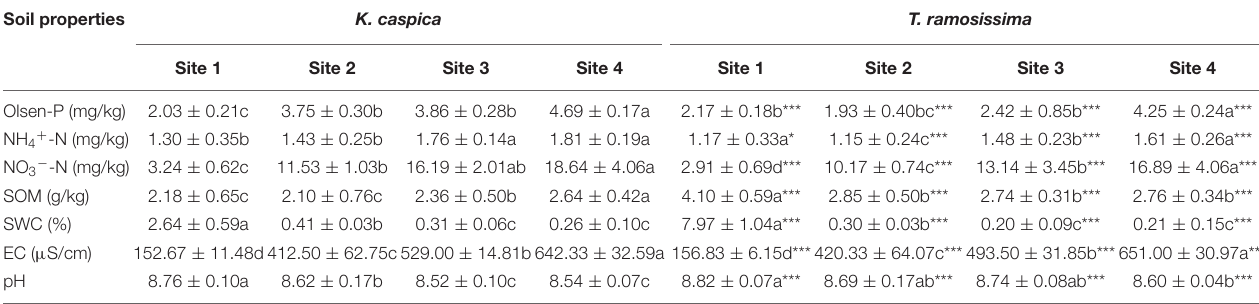
TABLE 1 | Soil properties beneath two desert plants at the four study sites.